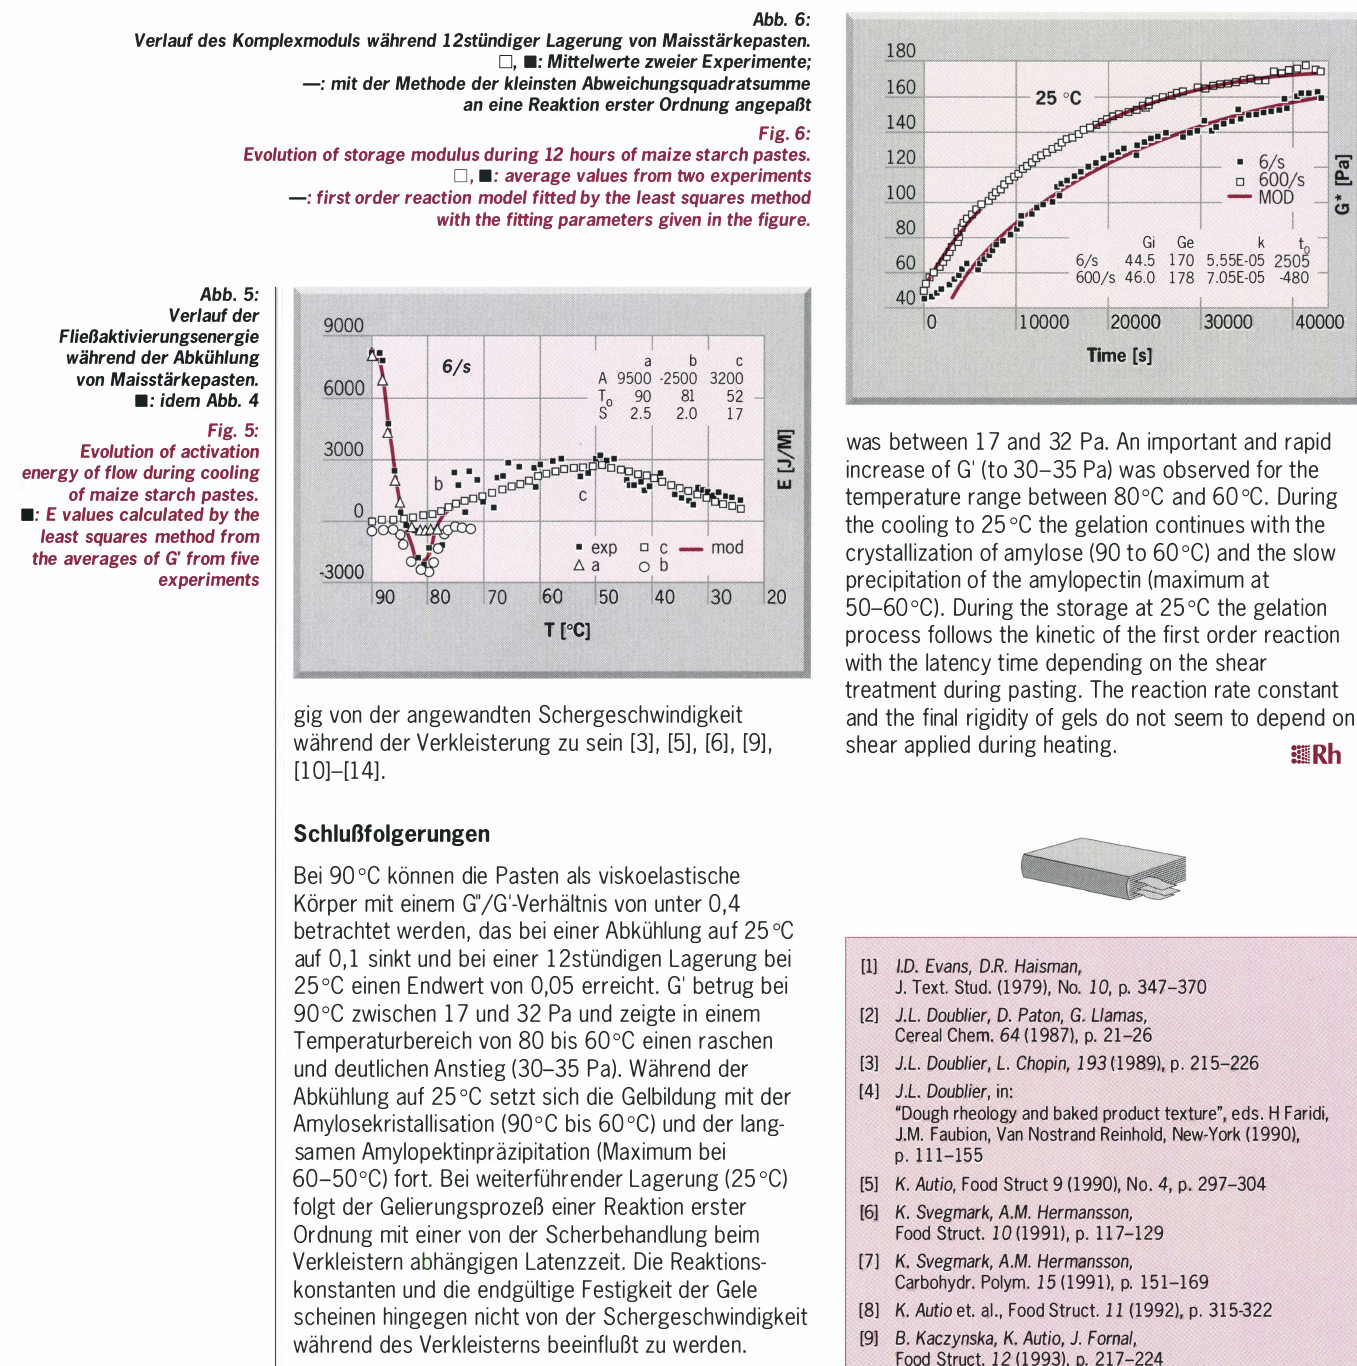
Evolution of storage modulus during 12 hours of maize starch pastes.